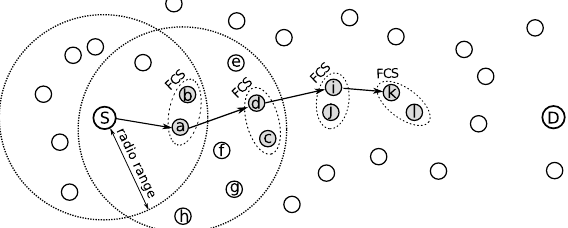
Figure 1. Principle of the anycast MAC